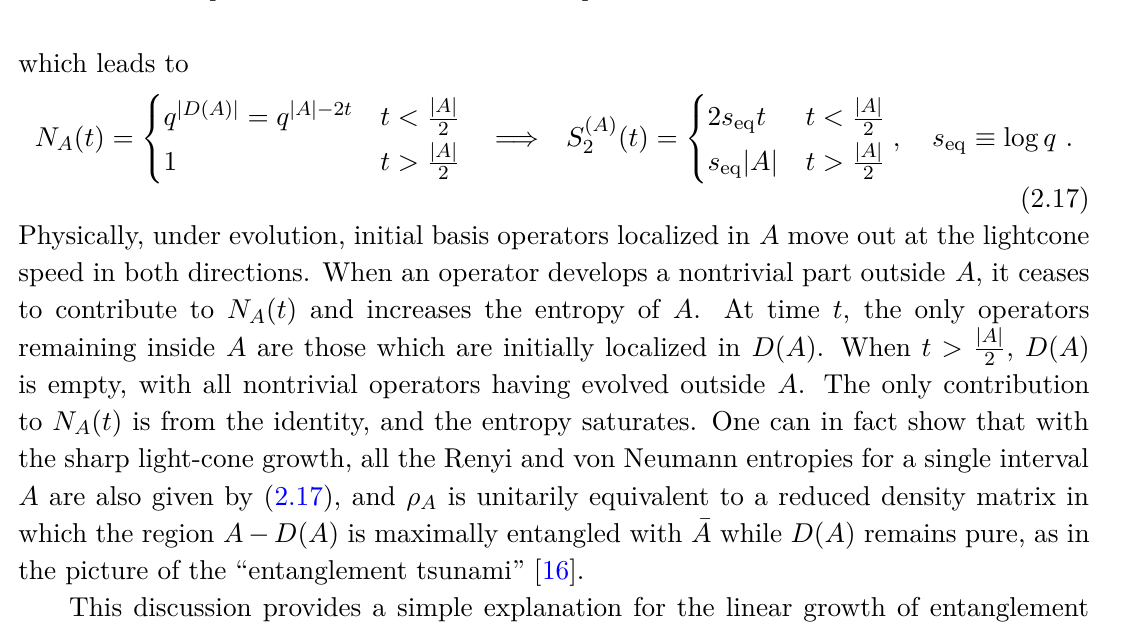
Figure 4 . Left: t < | A | / 2 . Right: t > | A | / 2 . D ( A ) is the intersection of the past domain dependence of A with the t = 0 slice, which becomes empty for t > | A | / 2 . J ( A ) is the region at t = 0 which is causally connected with A . At t < | A | / 2 , every operator in J ( A ) has zero probability of transitioning to a final operator contained in ¯ A = B 1 B 2 . At t ≥ | A | / 2 , an operator in J ( A ) can transition to an operator contained in ¯ A if it develops a void in A